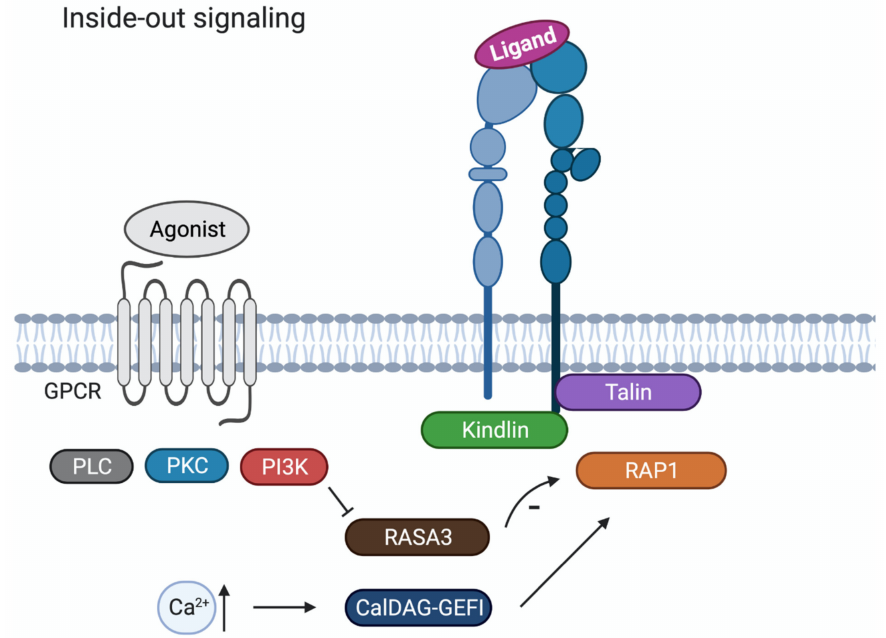
Figure 2. Schematic overview of inside-out signalling in platelets. Agonist activation of G protein- coupled receptor triggers signalling pathways with key signalling proteins like phospholipase C (PLC), protein kinase C (PKC) and phosphatidylinositide-3-kinase (PI3K). Increased Ca 2+ will lead to activation of CalDAG-GEFI that will activate Ras-related protein 1 (RAP1). RASA3 acts as a negative regulator of RAP1 activation, and RASA3 activity is restricted by PI3K activation. Through the separation of the talin head and tail domain, the talin head domain associates with the cytoplasmic tail of the β 3 subunit, converting the integrin α IIb β 3 from the inactive to the active form. Platelet activation induced by the binding of soluble agonists (e.g., ADP, thrombin, thromboxane A2) or adhesive ligands (e.g., collagen, VWF, fibrinogen) to their